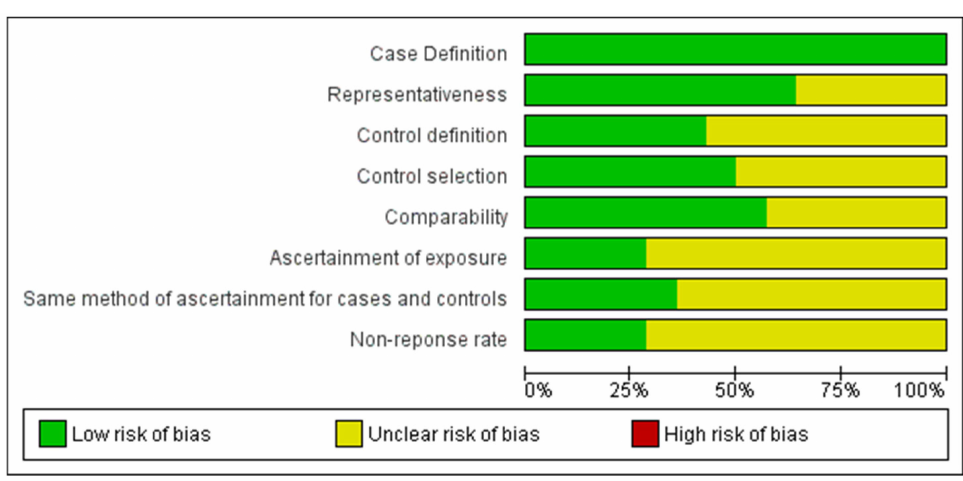
Figure 2. Risk of bias assessment graph and summary.